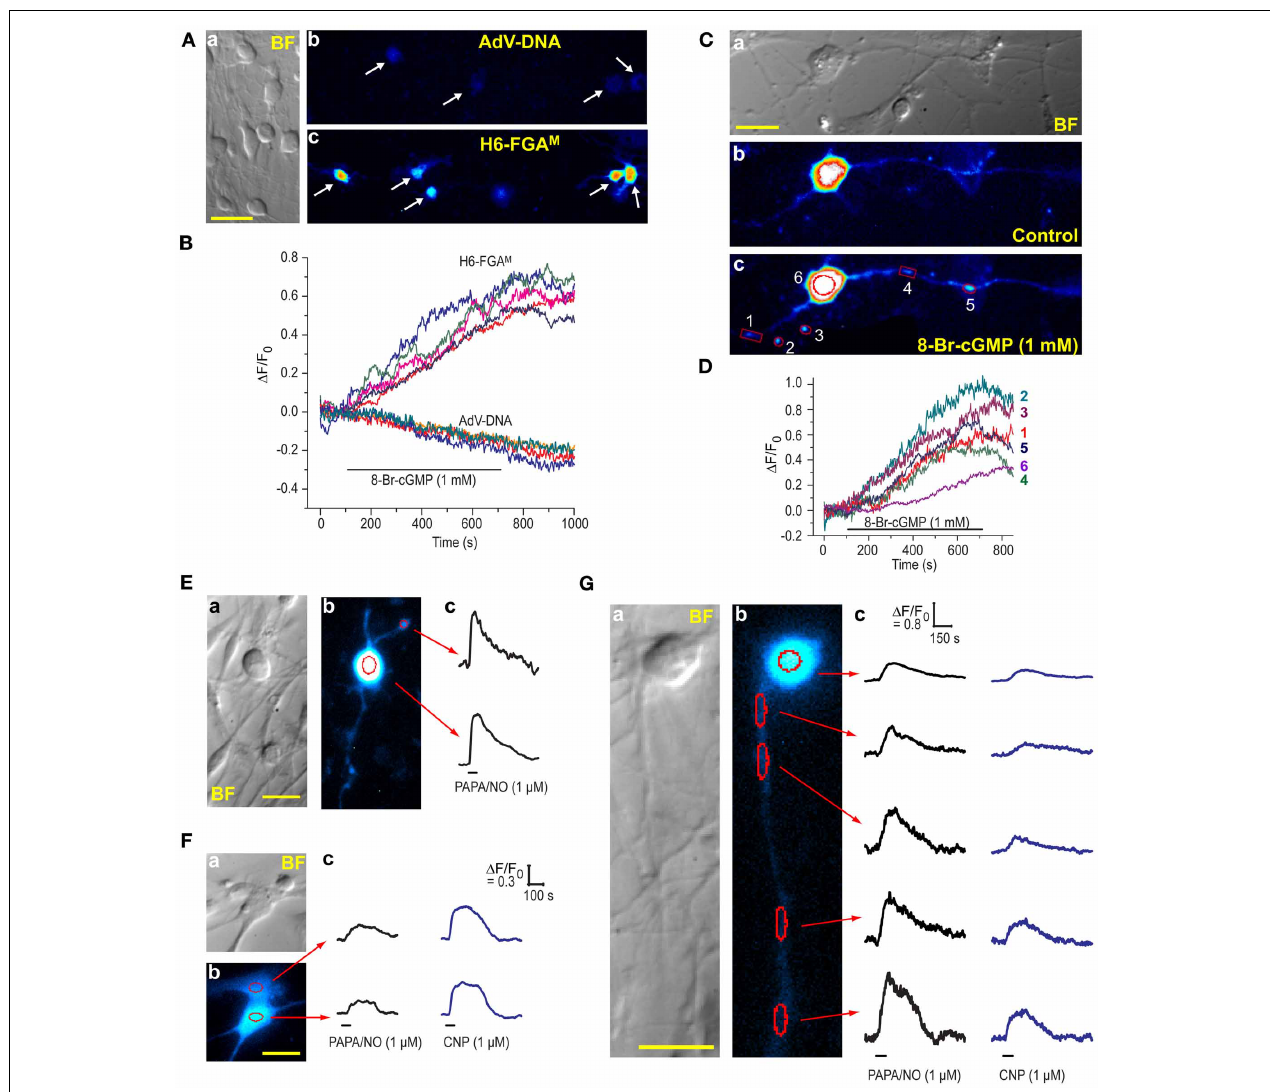
FIGURE 7 | Expression of H6-FGA M in DRG cultures. (A) (a) Brightfield image of a typical culture showing neurones of different sizes and an underlay of flatter, glial-like cells. (b,c) Fluorescence images of cultures after attempted transfection with AdV-FlincG plasmid DNA (b) and H6-FGA M (c) and exposure to 1mM 8-bromo-cGMP for 10min. Scale bar (a) = 50 μ m. (B) Time-courses of fluorescent changes in the individual cells arrowed in (A b ) and (A c ) during superfusion of 8-bromo-cGMP. (C) High-power brightfield (a) and fluorescence (b,c) images of a transfected neurone before (b) and after (c) superfusion of 8-bromo-cGMP (1mM) for 8min. The images in (b) and (c) were processed identically. Scale bar (a) = 25 μ m. (D) Time-course of the changes in fluorescence in the